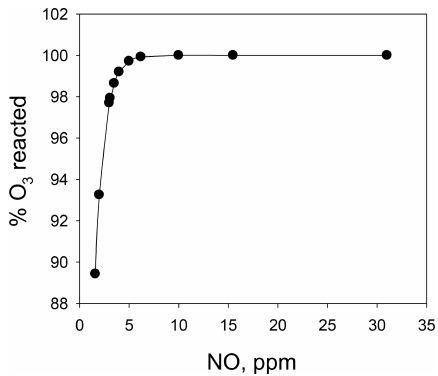
Figure 1. A plot of the percent of O 3 consumed vs. the initial NO concentration for the conditions of [ NO ] = 2 ×[ O 3 ] and a total re- action time of